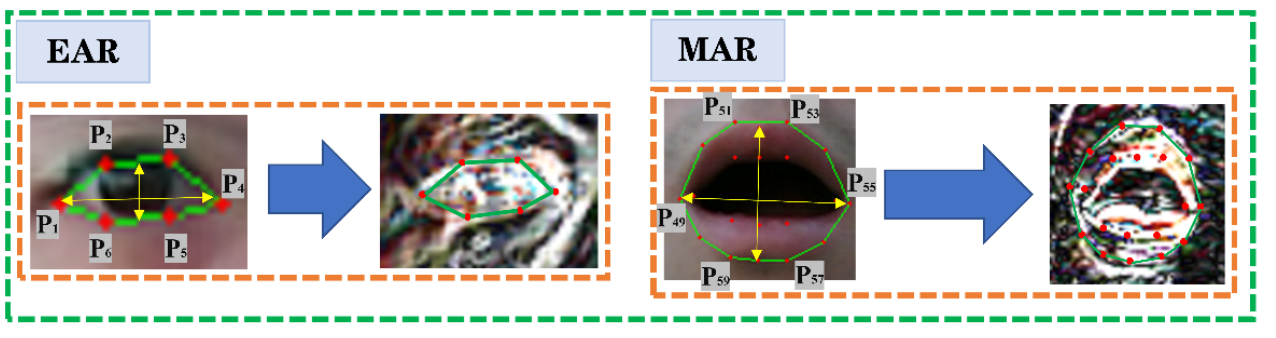
Figure 6. Schematic diagram of EAR and